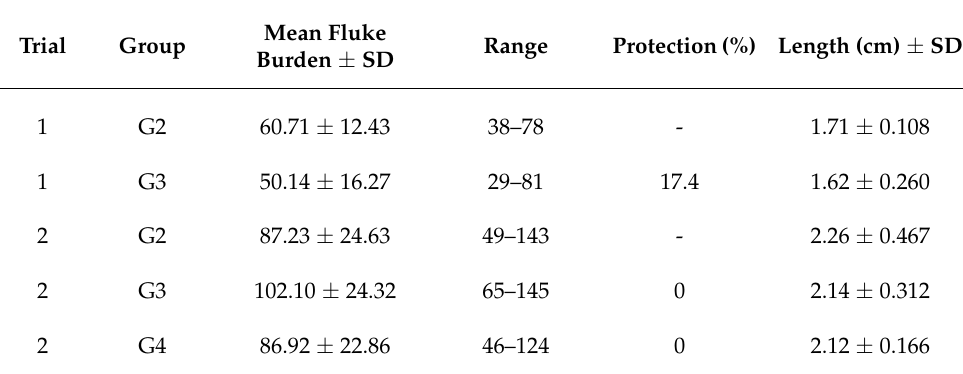
Table 1. Number and mean size of adult liver fluke recovered at